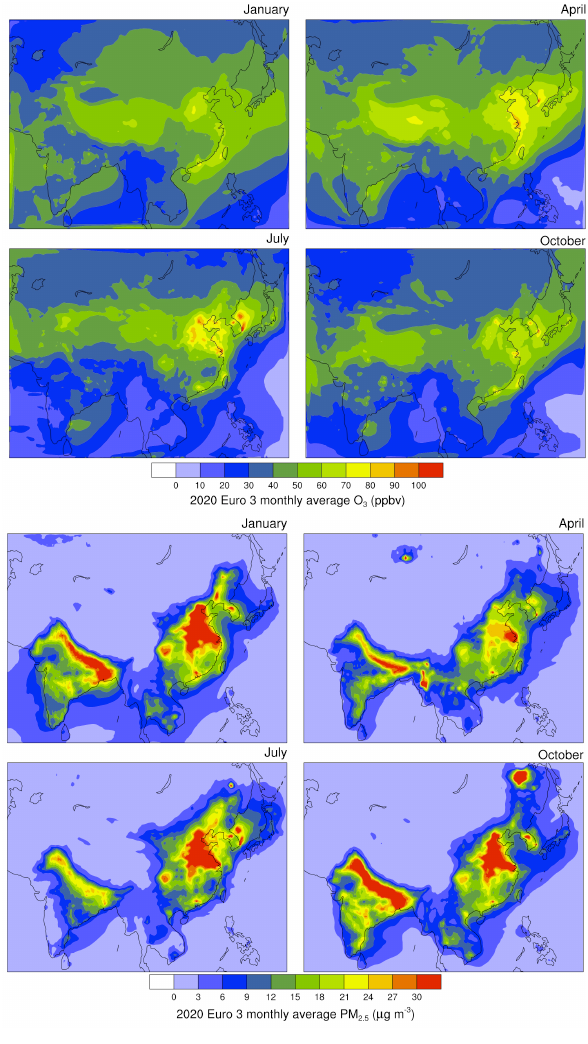
Fig. 11. The surface O 3 mixing ratios [ppbv] (top) and PM 2.5 concentrations [ µ g m -3 ] (bottom) in January April, July and October modelled by WRF/Chem for 2020 Euro 3 scenario.